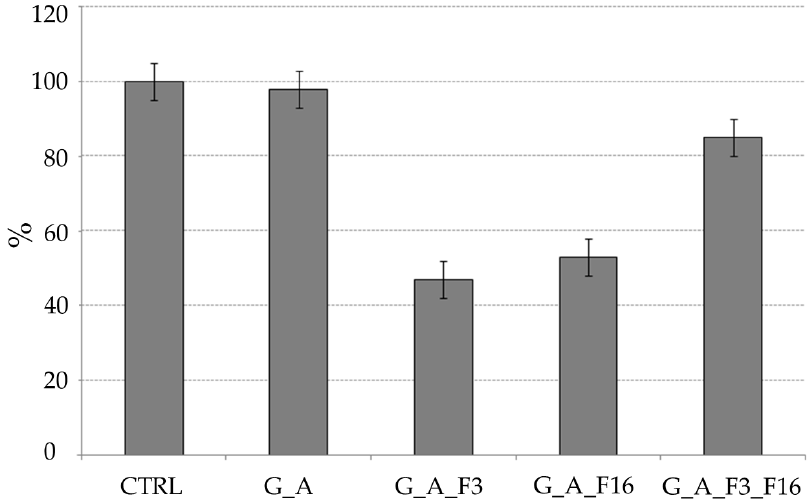
Figure 21. Percentage of bacterial adhesion in contact with untreated (control, CTRL) and treated glasses (G_A, G_A_F3, G_A_F16, and G_A_F3_F16). Area covered by adhering organisms has been estimated by staining with DAPI and counting under epifluorescent microscope.